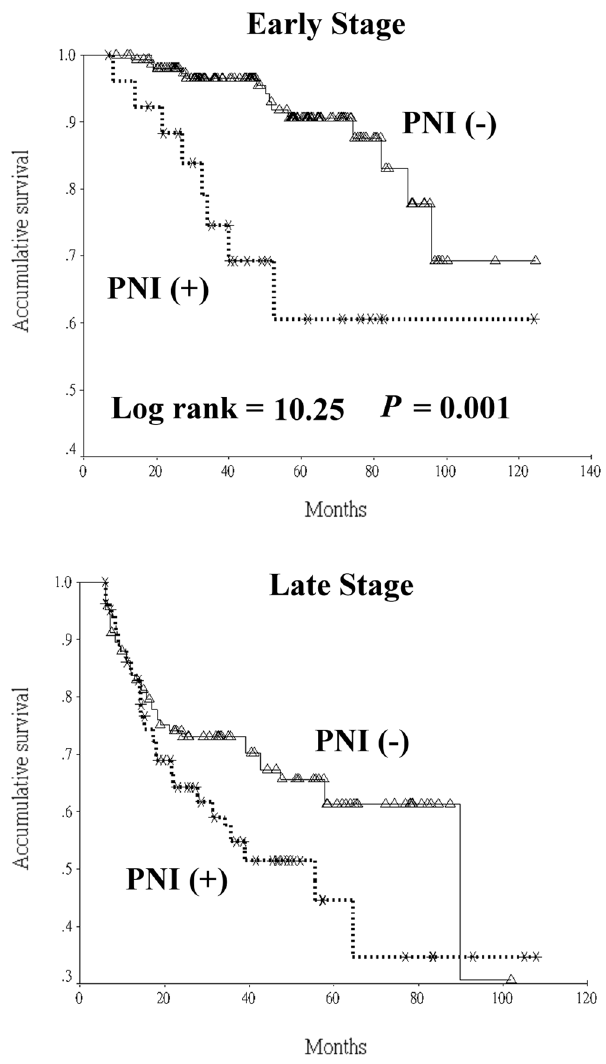
Figure 1. Univariate analysis of the presence of perineural invasion (PNI) on disease-specific survival stratified according to initial pathological stage in tongue squamous cell carcinoma